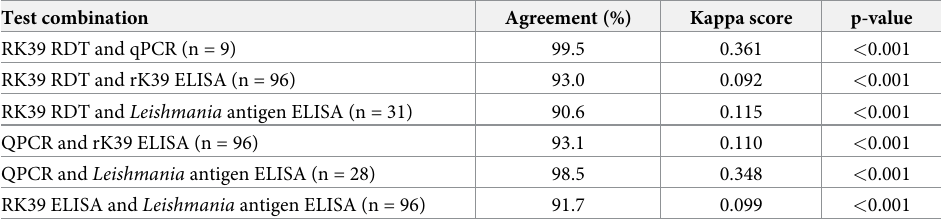
Table 7. Kappa scores and agreement for the rK39 RDT, rK39 ELISA, qPCR, and Leishmania antigen ELISA in 96 people living with HIV (PLHIV) with asymptomatic Leishmania infection (ALI) in Bihar, India. Test combination Agreement (%) Kappa score p-value RK39 RDT and qPCR (n = 9) 99.5 0.361 < 0.001 RK39 RDT and rK39 ELISA (n = 96) 93.0 0.092 RK39 RDT and Leishmania antigen ELISA (n = 31) 90.6 0.115 QPCR and rK39 ELISA (n = 96) 93.1 QPCR and Leishmania antigen ELISA (n = 28) 98.5